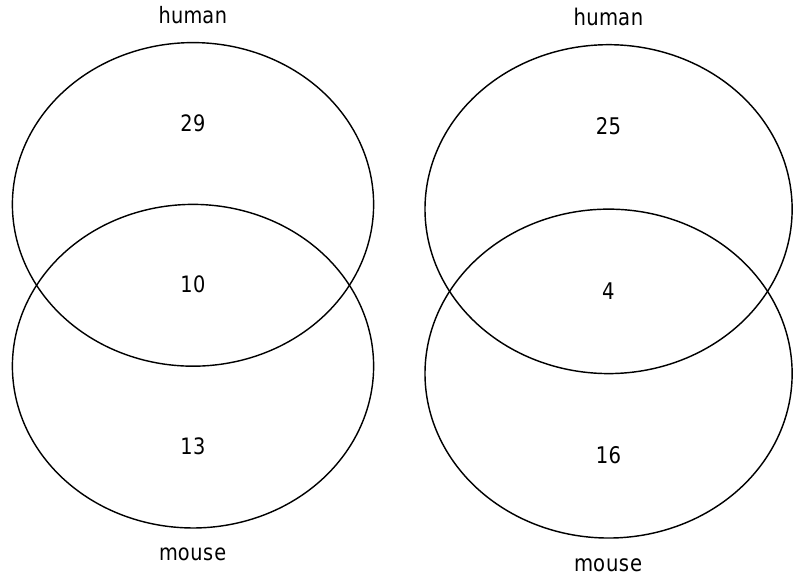
Figure 10. Venn diagram of diseases in "Disease Perturbations from GEO down" ( left ) and "Disease Perturbations from GEO up" ( right ) categories, selected by uploading genes selected by TD-based unsupervised FE to